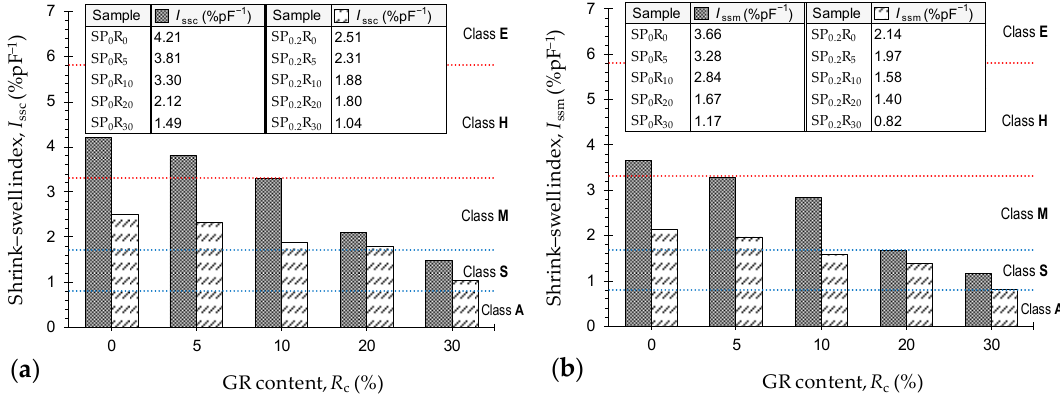
Figure 9. Variations of the shrink–swell index against GR content for the natural soil and various GR-blended samples— SP x R y where x = {0, 0.2}, and y = {0, 5, 10, 20, 30}: ( a ) Conventional approach I ssc ; and ( b ) Modified approach I ssm .